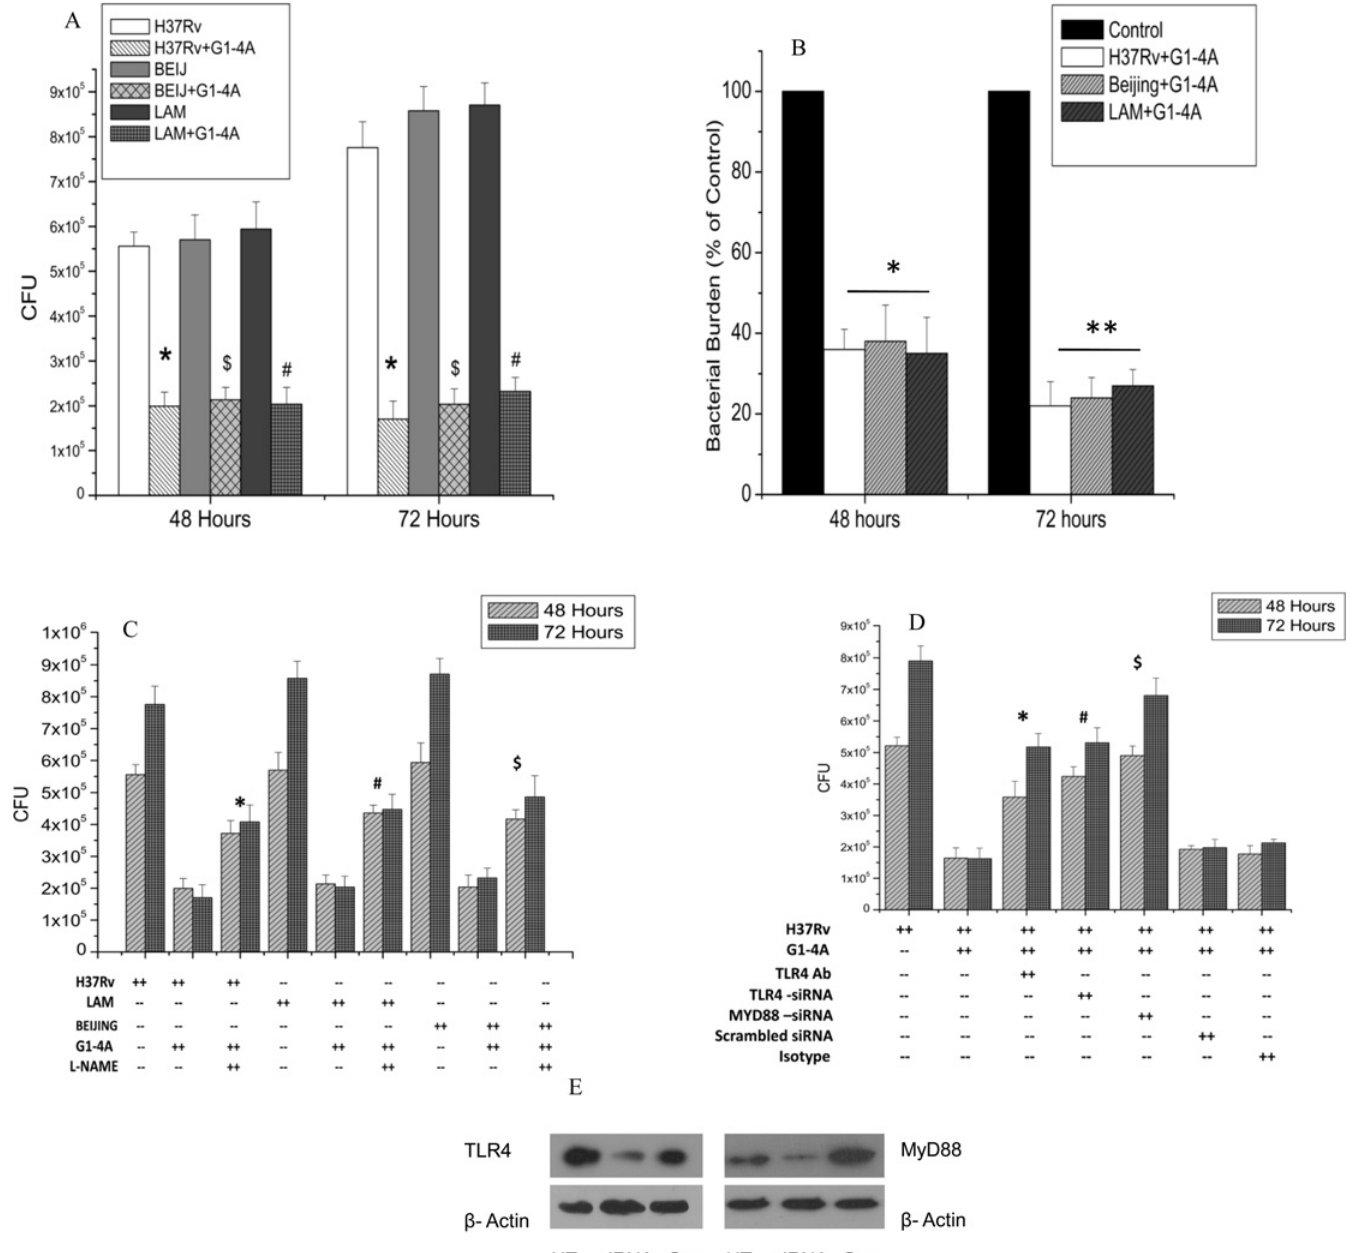
Fig 5. Inhibition of intracellular survival of MTB strains in macrophages by G1-4A. (A) CFU counts of three strains of MTB in presence or absence of G1-4A ( * p < 0.01 as compared to untreated H37Rv infected control, #p < 0.01 compared to untreated LAM infected control and $p < 0.01 compared to untreated Beijing infected control). (B) Bacterial burden (Percentage of control, * p < 0.05, ** p < 0.01). (C) CFU assay of RAW cells infected with MTB strains and treated with G1-4A in the presence or absence pharmacological inhibitor of NOS2, L-NAME (100 μ M), and incubated for 48 and 72 h. (D) Cells were infected with MTB H37Rv and incubated in the presence of anti TLR-4 blocking antibodies or isotype control antibodies for 2 h followed by treatment with G1-4A for 48 and 72h. In other set of experiments, expression of TLR4 and MyD88 was transiently knocked down by adding siRNA against TLR4 and MyD88. Scrambled siRNA was used as control. Later, cells were infected with H37Rv and treated with G1-4A for 48 and 72 h. Figure depicts CFU data for both the sets of experiments. (E) Immunoblotting of TLR4 and MyD88 in RAW cells after siRNA treatment. Results shown are representative of at least three independent experiments and presented here as mean ± SD, * p < 0.05 as compared to only G1-4A treated H37Rv infected control, #p < 0.05 compared to only G1-4A treated LAM infected control and $p < 0.05 compared to only G1-4A treated Beijing infected